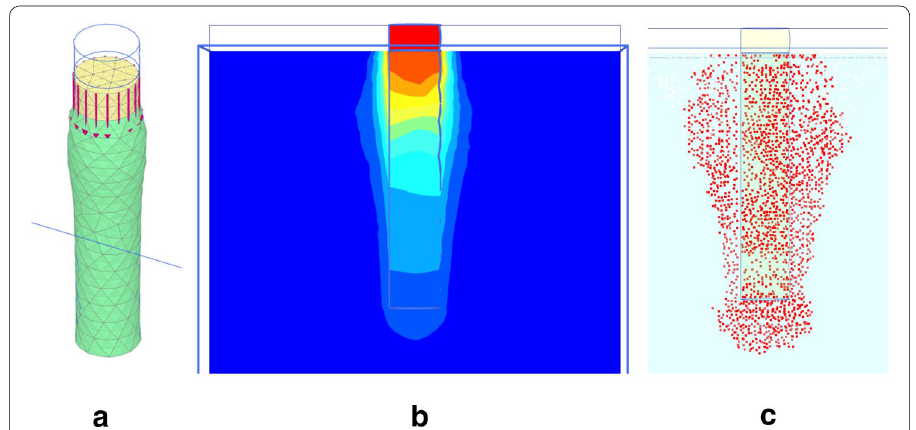
Fig. 5 Column with C u column; c plastic